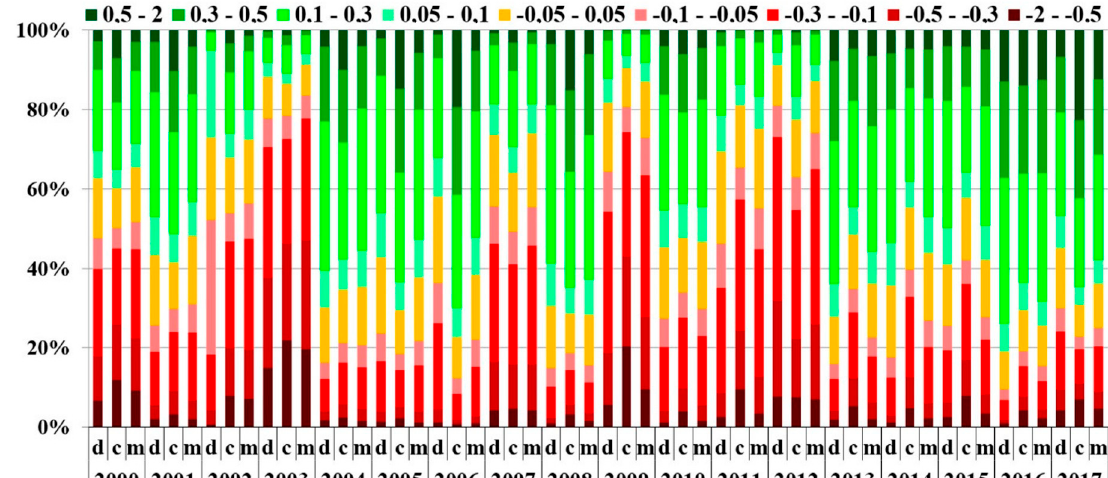
Figure 8. EVI yearly standardized deviation rates for di ff erent forest types between 2000 and 2017, based on MODIS MVC images (d: deciduous, c: coniferous, m: mixed